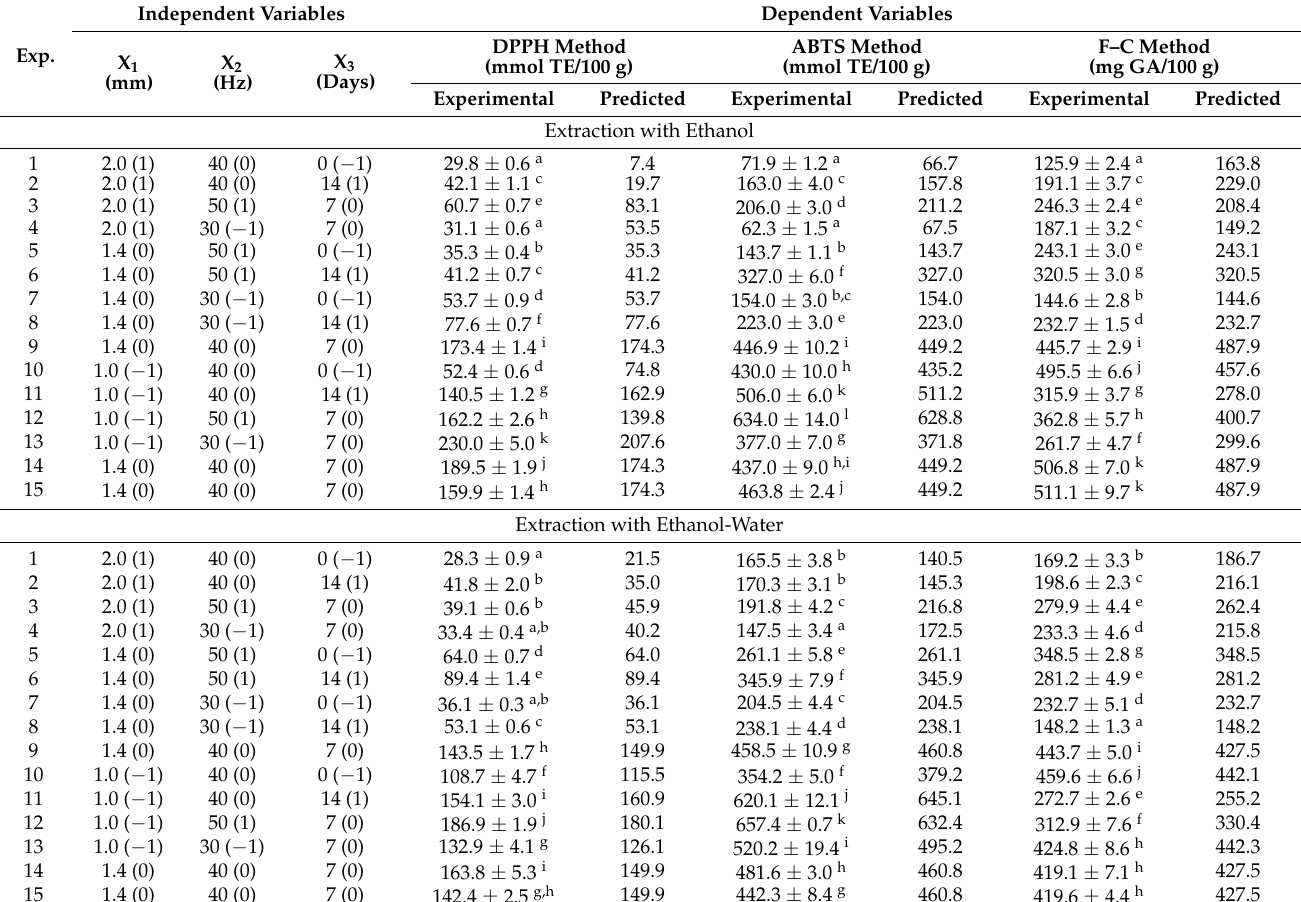
Table 2. Three-level Box–Behnken design with experimental ( x ± SD ) and predicted results for the antioxidant properties of